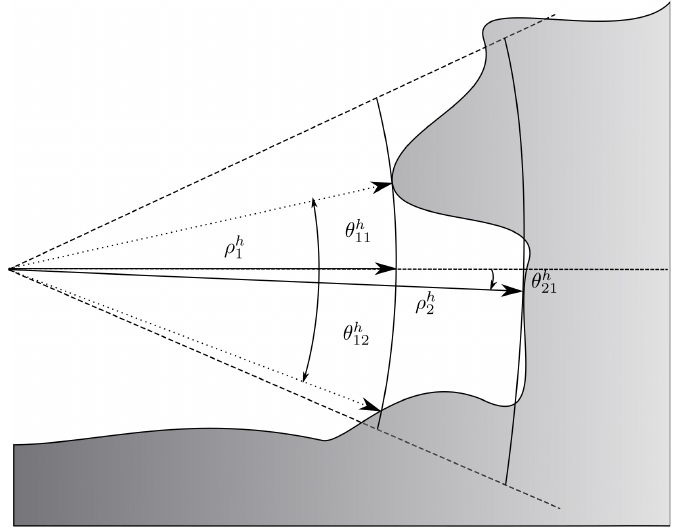
Figure 4. A single measure from the horizontal sonar can correspond to several 3D points and in consequence to several elevation